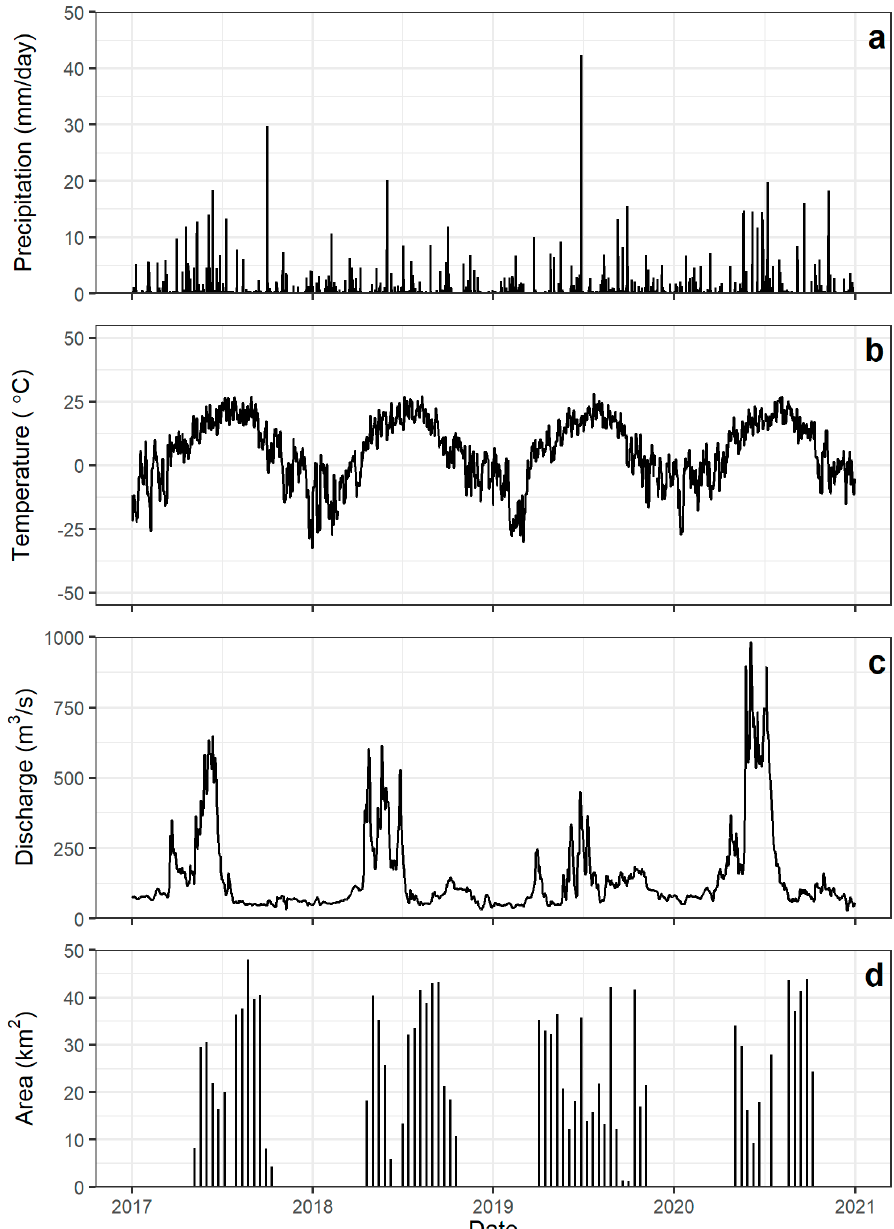
Figure 6. ( a ) Total daily precipitation; ( b ) mean daily temperature; ( c ) daily river discharge; ( d ) flooded area for the South Saskatchewan River at Medicine Hat, Alberta.